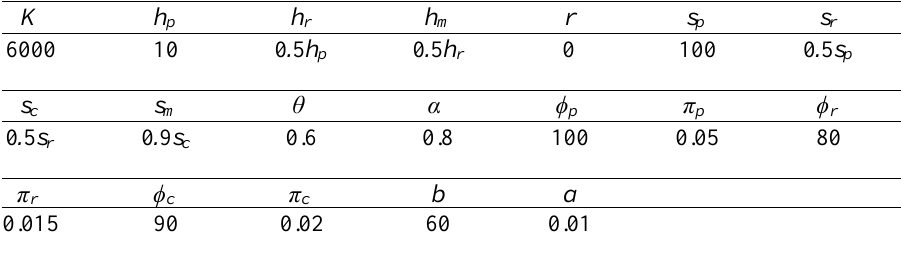
Table 1. Parameter values for Example 1.